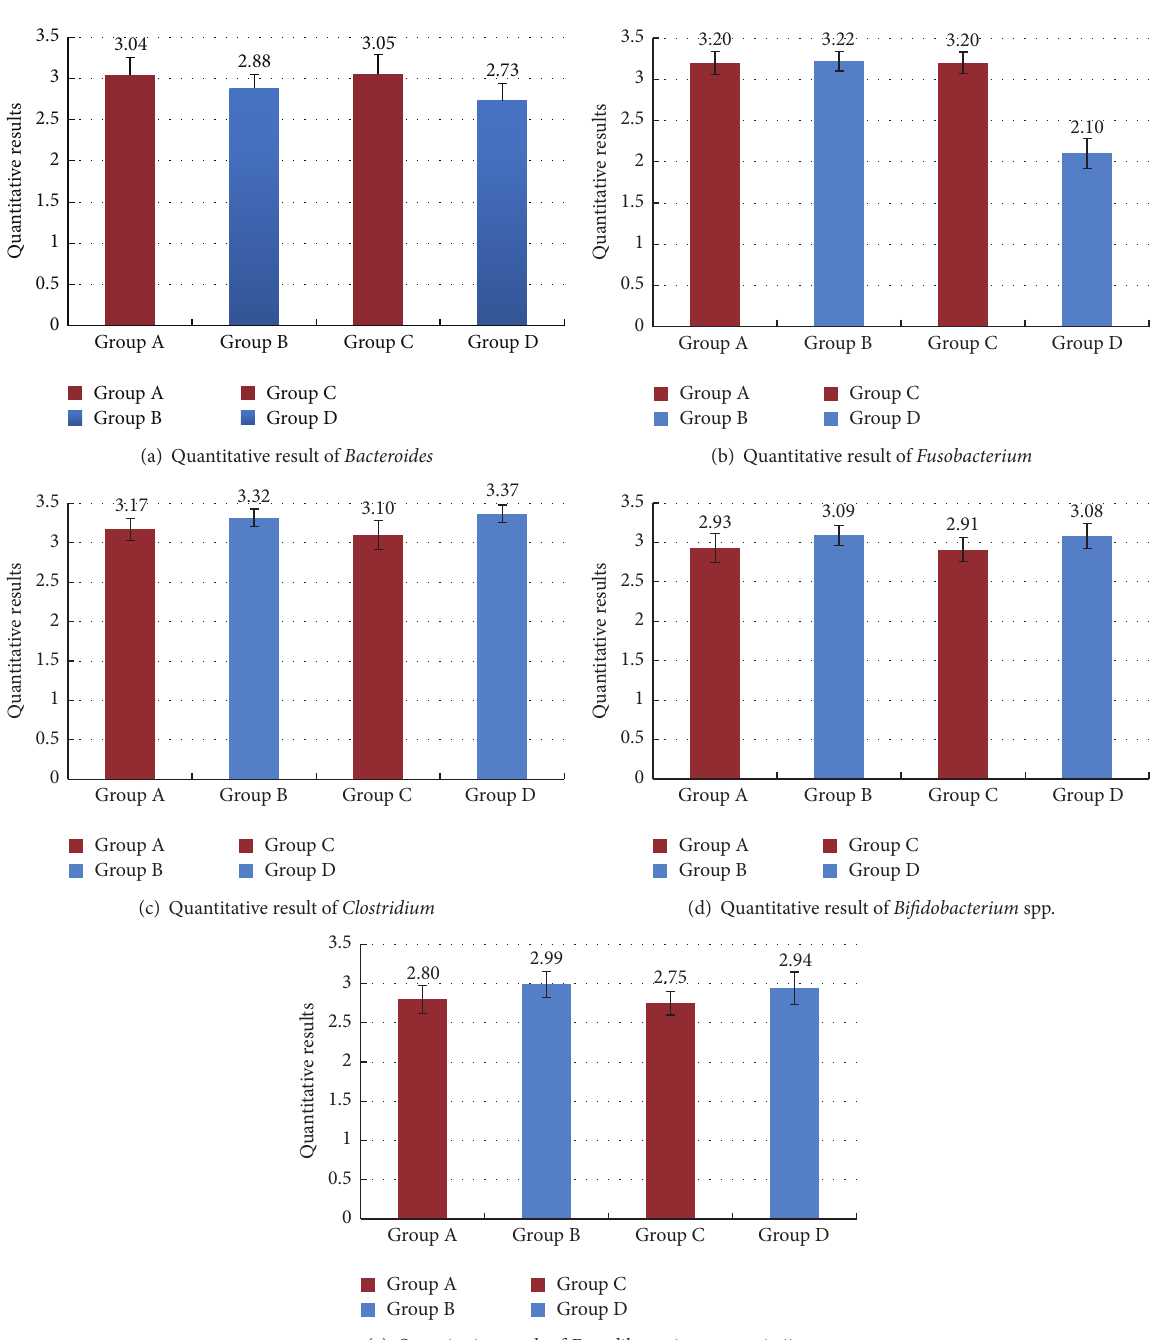
Figure 2: (a) Quantitative analysis of copy numbers of Bacteroides in the 4 groups: A, Han-UC group; B, Han-control group; C, Uygur- UC group; D, Uygur-control group. UC, ulcerative colitis. (b) Quantitative analysis of copy numbers of Fusobacterium in the 4 groups: A, Han-UC group; B, Han-control group; C, Uygur-UC group; D, Uygur-control group. UC, ulcerative colitis. (c) Quantitative analysis of copy numbers of Clostridium prausnitzii in the 4 groups: A, Han-UC group; B, Han-control group; C, Uygur-UC group; D, Uygur-control group. UC, ulcerative colitis. (d) Quantitative analysis of copy numbers of Bifidobacterium spp. in the 4 groups: A, Han-UC group; B, Han-control group; C, Uygur-UC group; D, Uygur-control group. UC, ulcerative colitis. (e) Quantitative analysis of copy numbers of Faecalibacterium prausnitzii in the 4 groups: A, Han-UC group; B, Han-control group; C, Uygur-UC group; D, Uygur-control group. UC, ulcerative